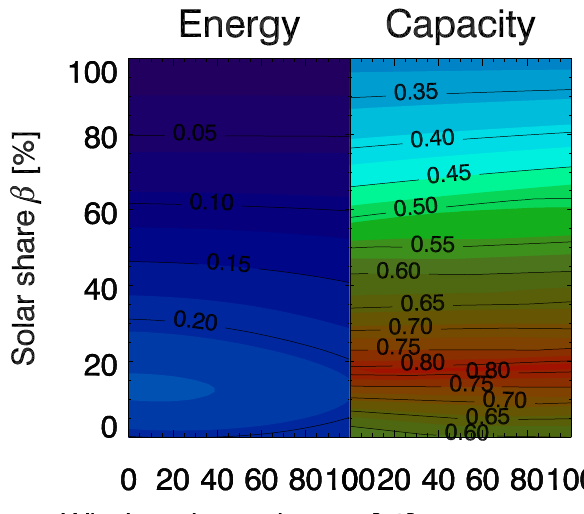
Figure 4. Reduction of relative storage energy (left) and storage ca- pacity (right) needs for an increase of the installation factor α = 1.0 to 1.1 for a Europe with unlimited transmission in dependency of the solar β and wind onshore share γ .